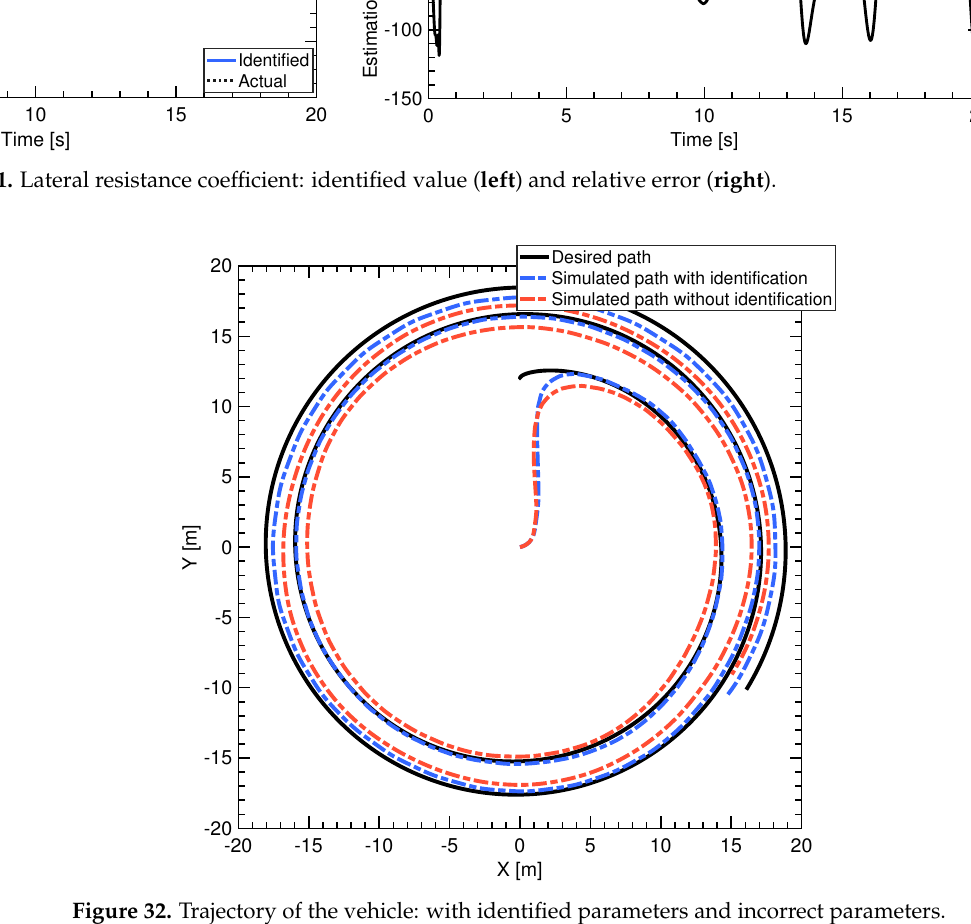
Figure 32. Trajectory of the vehicle: with identified parameters and incorrect